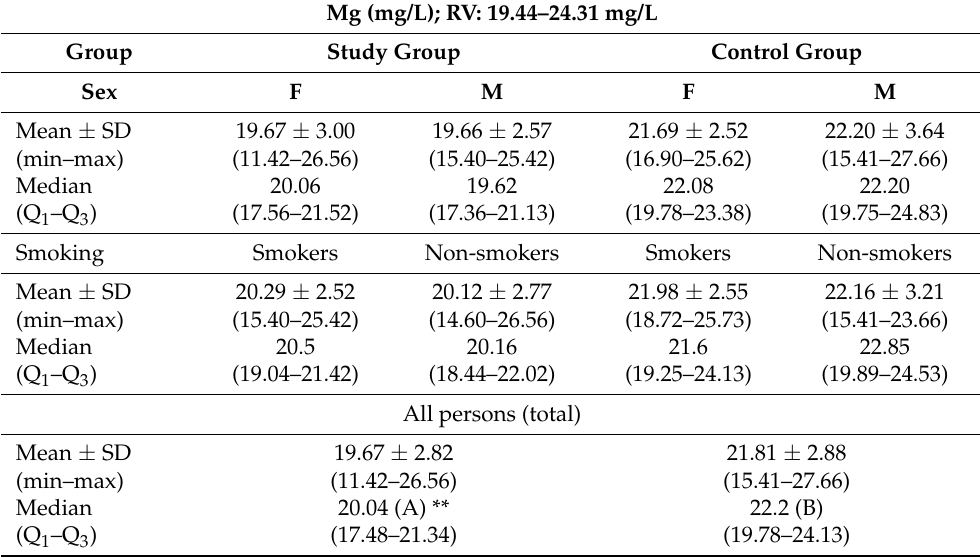
Table 2. The concentration of magnesium in the serum of patients with osteoarthritis of the spine and healthy people.